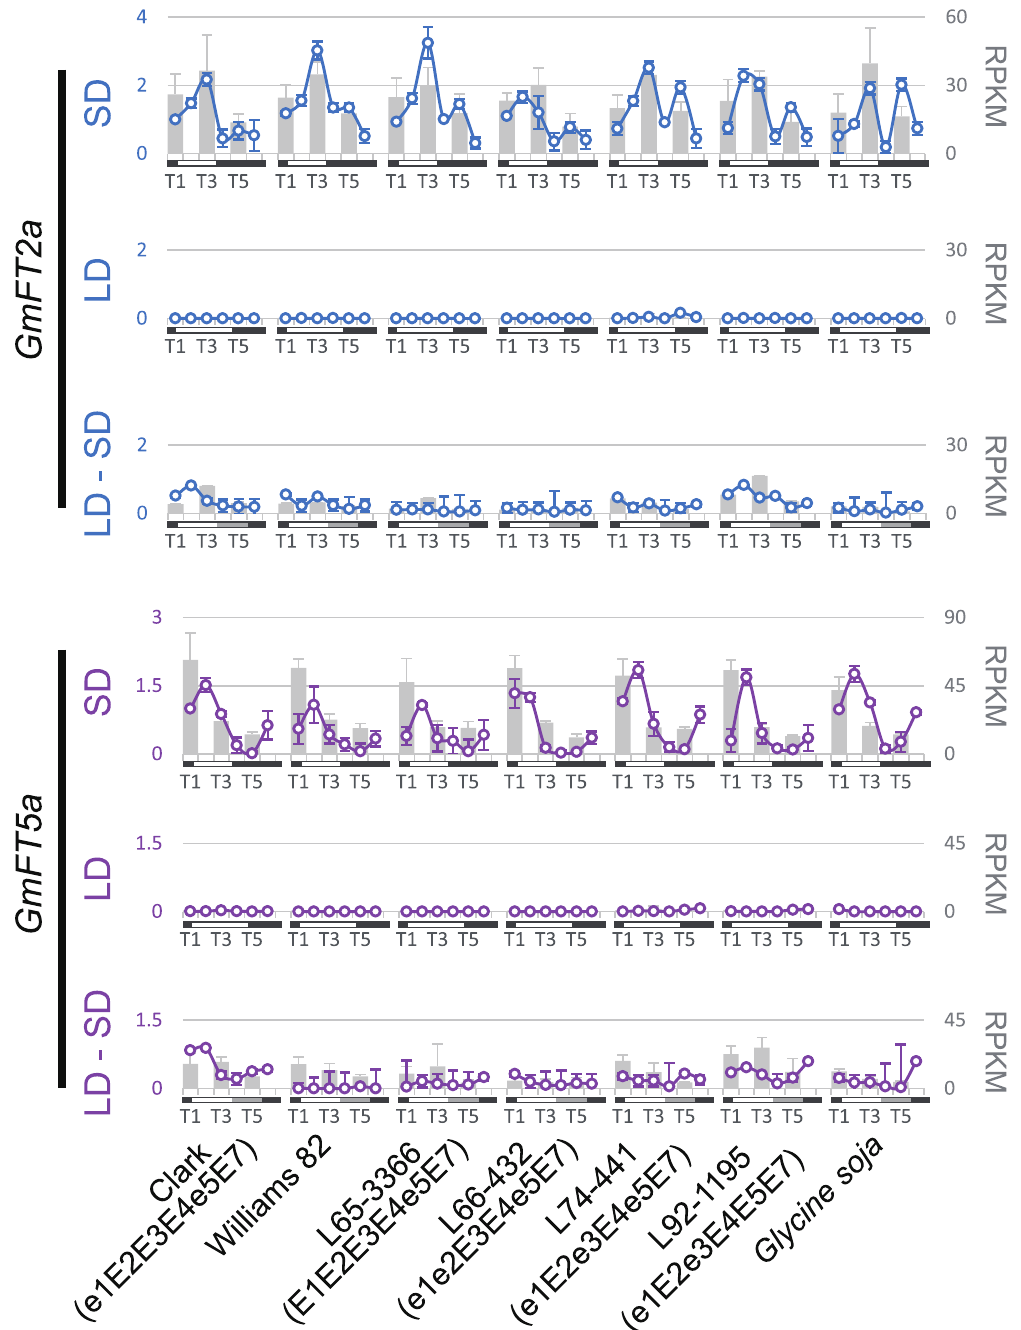
Figure 5. mRNA abundance of GmFT2a and GmFT5a . Circles and solid lines represent the data obtained by qRT-PCR, and gray bars represent the data obtained by RNA sequencing. Relative expression levels of qRT-PCR among the samples in each panel are shown on the left, and RPKM values of RNA sequencing are shown on the right. SD is 10 hours light (6:45–16:45), LD is 16 hours light (6:45–22:45) and LD-SD is a shift from three weeks LD to 5 days SD. Time points T1–T6 represent 6:30, 10:30, 14:30, 18:30, 22:30 and 2:30. Note that RNA sequencing samples contain three representative time points: T1, T3 and T5.